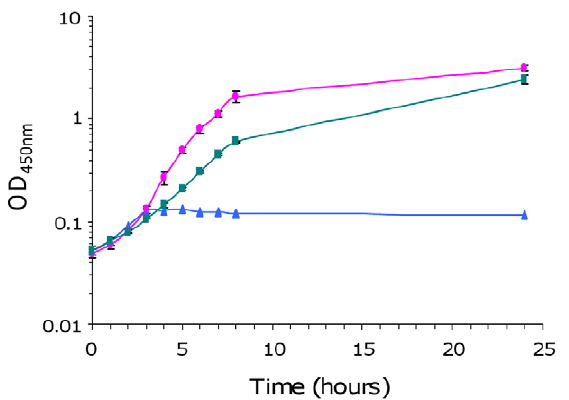
Figure 4. Competition between E. coli strains BEN2908 and BEN2908 D fosT for growth in the presence of liver extract. Growth curves (log 10 CFU/ml) of strains BEN2908 (pink circle) and BEN2908 D fosT (blue triangle) grown without shaking at 37 u C in M9 minimal medium supplemented with 4% of liver extract. The average values and standard deviations result from three independent experiments.